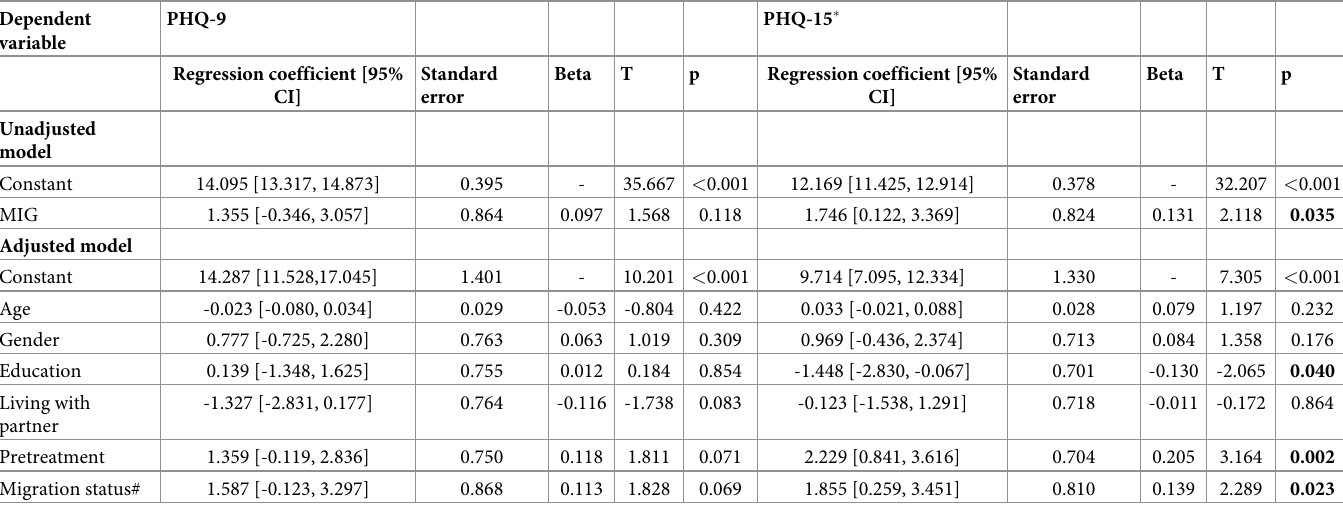
Table 2. Results of multiple linear regression analysis at admission